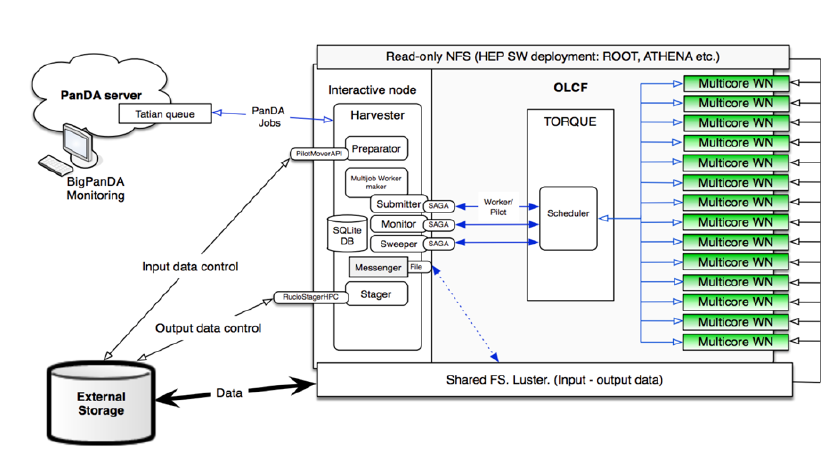
Figure 1: The components of ATLAS distributed computing software: production management (am- ber elements), metadata and distributed data management (blue elements), workload management (red Figure 2: Harvester deployment on Titan and its interaction with external PanDA services and Titan’s elements) batch